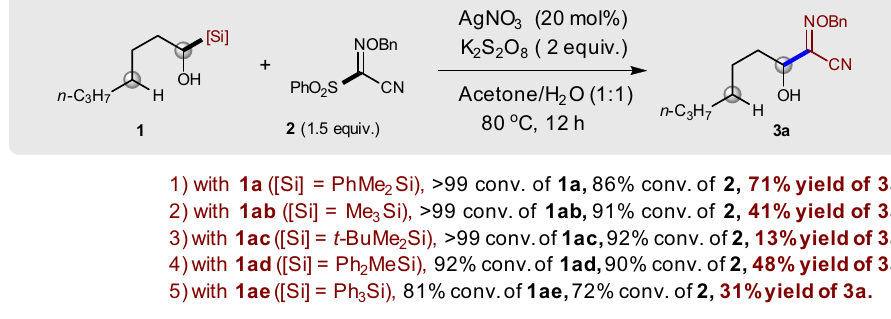
Fig. 3 In fl uence of silyl groups on the ef fi ciency of the reaction. Reaction conditions: the mixture of 1 (0.2 mmol), AgNO 3 (0.04 mmol), K 2 S 2 O 8 (0.4 mmol), 2 (0.3 mmol), and acetone/H 2 O (0.75 mL/0.75 mL) was stirred at 80 °C under N 2 for 12 h. Conversion of 1 and 2 and yield of 3a were determined by 1 H NMR using BrCH 2 CH 2 Br as an internal